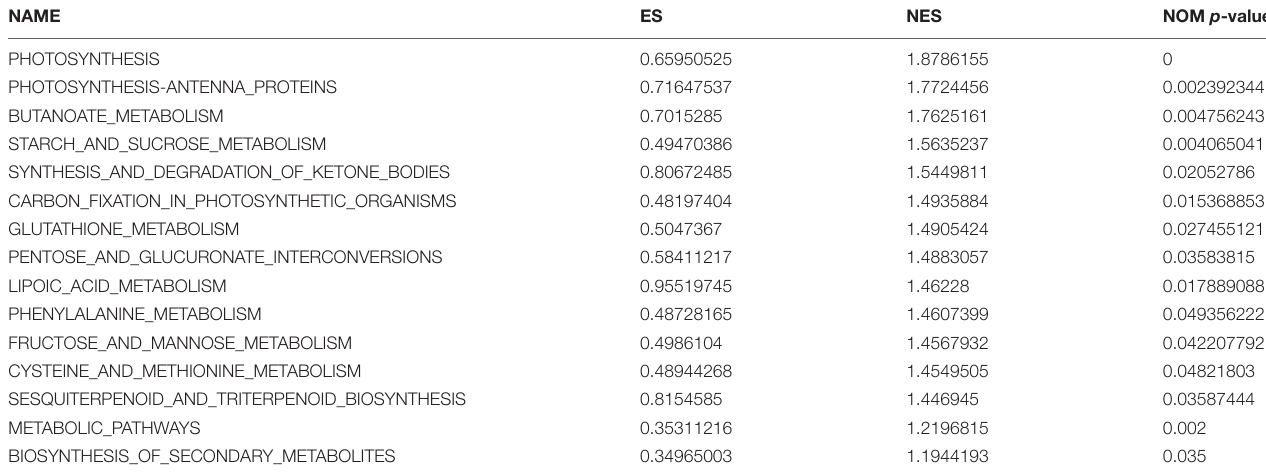
TABLE 2 | Kyoto Encyclopedia of Genes and Genomes enrichment analysis of transcriptome